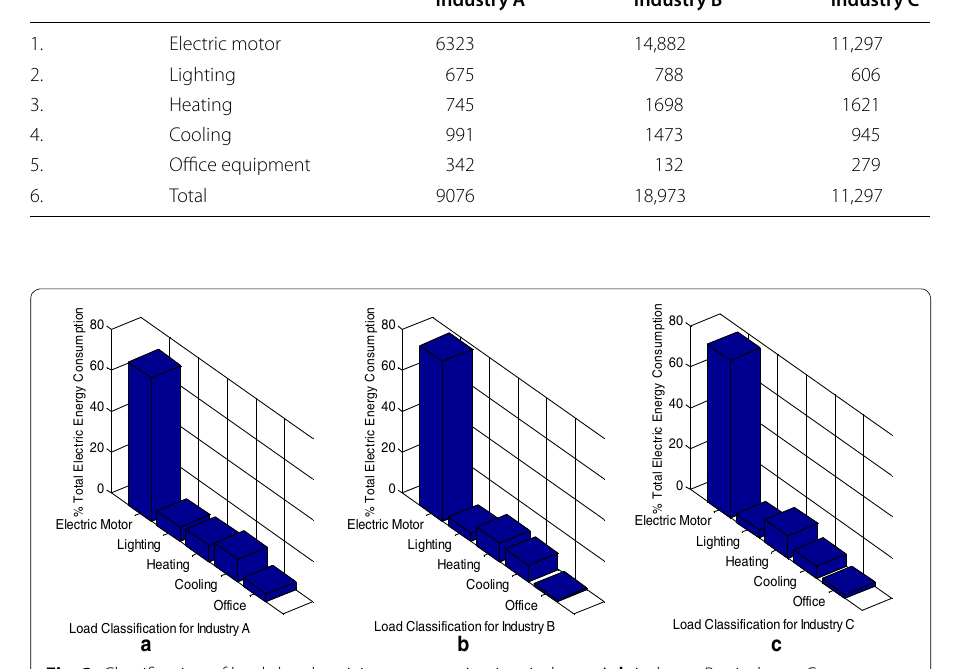
Fig. 3 Classification of loads by electricity consumption in a industry A, b industry B, c industry